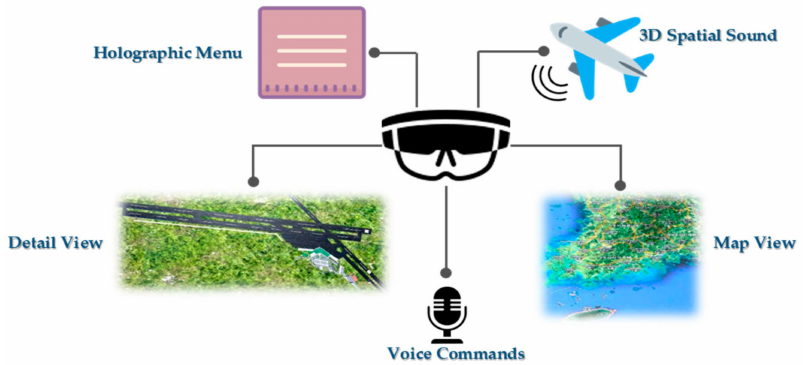
Figure 2. The proposed mixed reality system for air tra ffi c